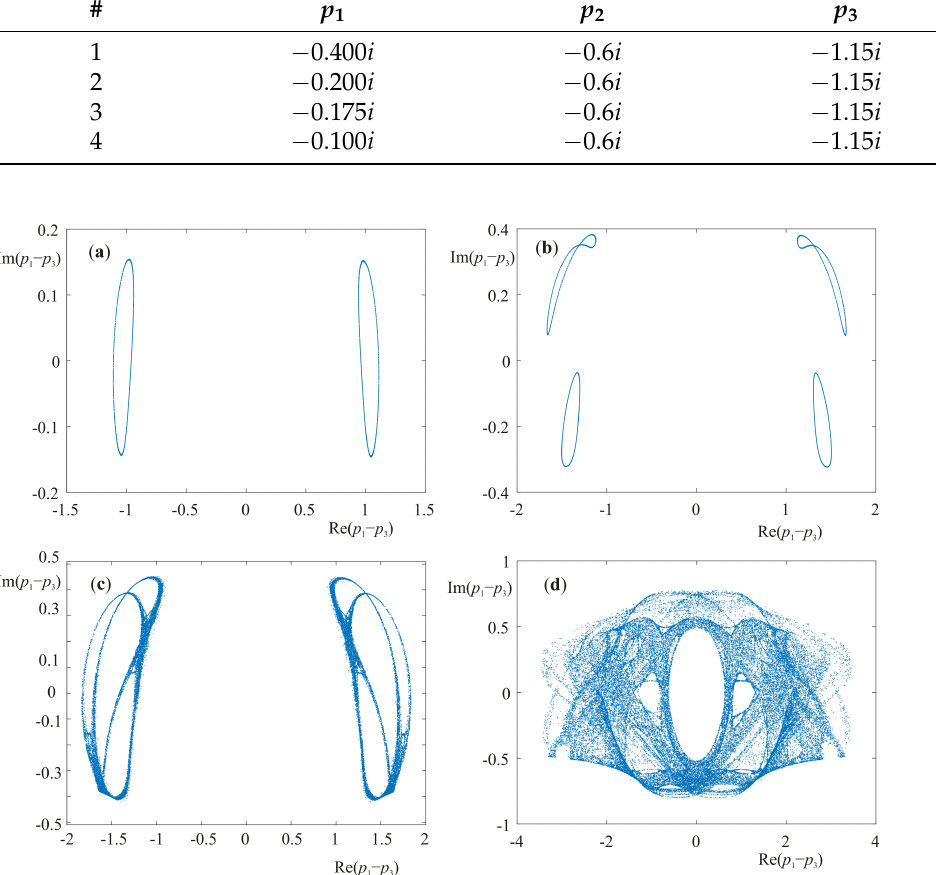
Figure 1. Poincaré sections are shown for the different initial conditions presented in Table 1: ( a – d ) correspond to 1, 2, 3, and 4 lines in Table 1,